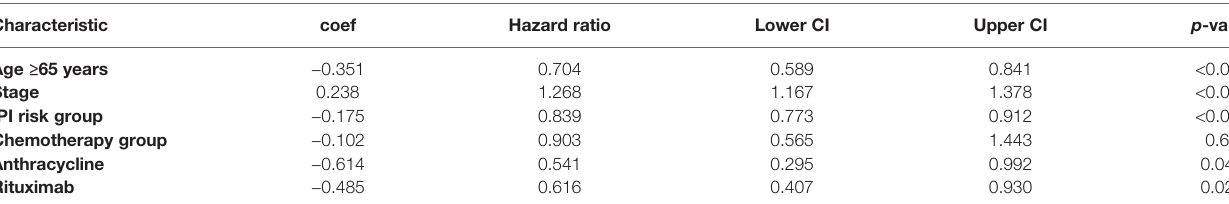
TABLE 3 | Multivariate